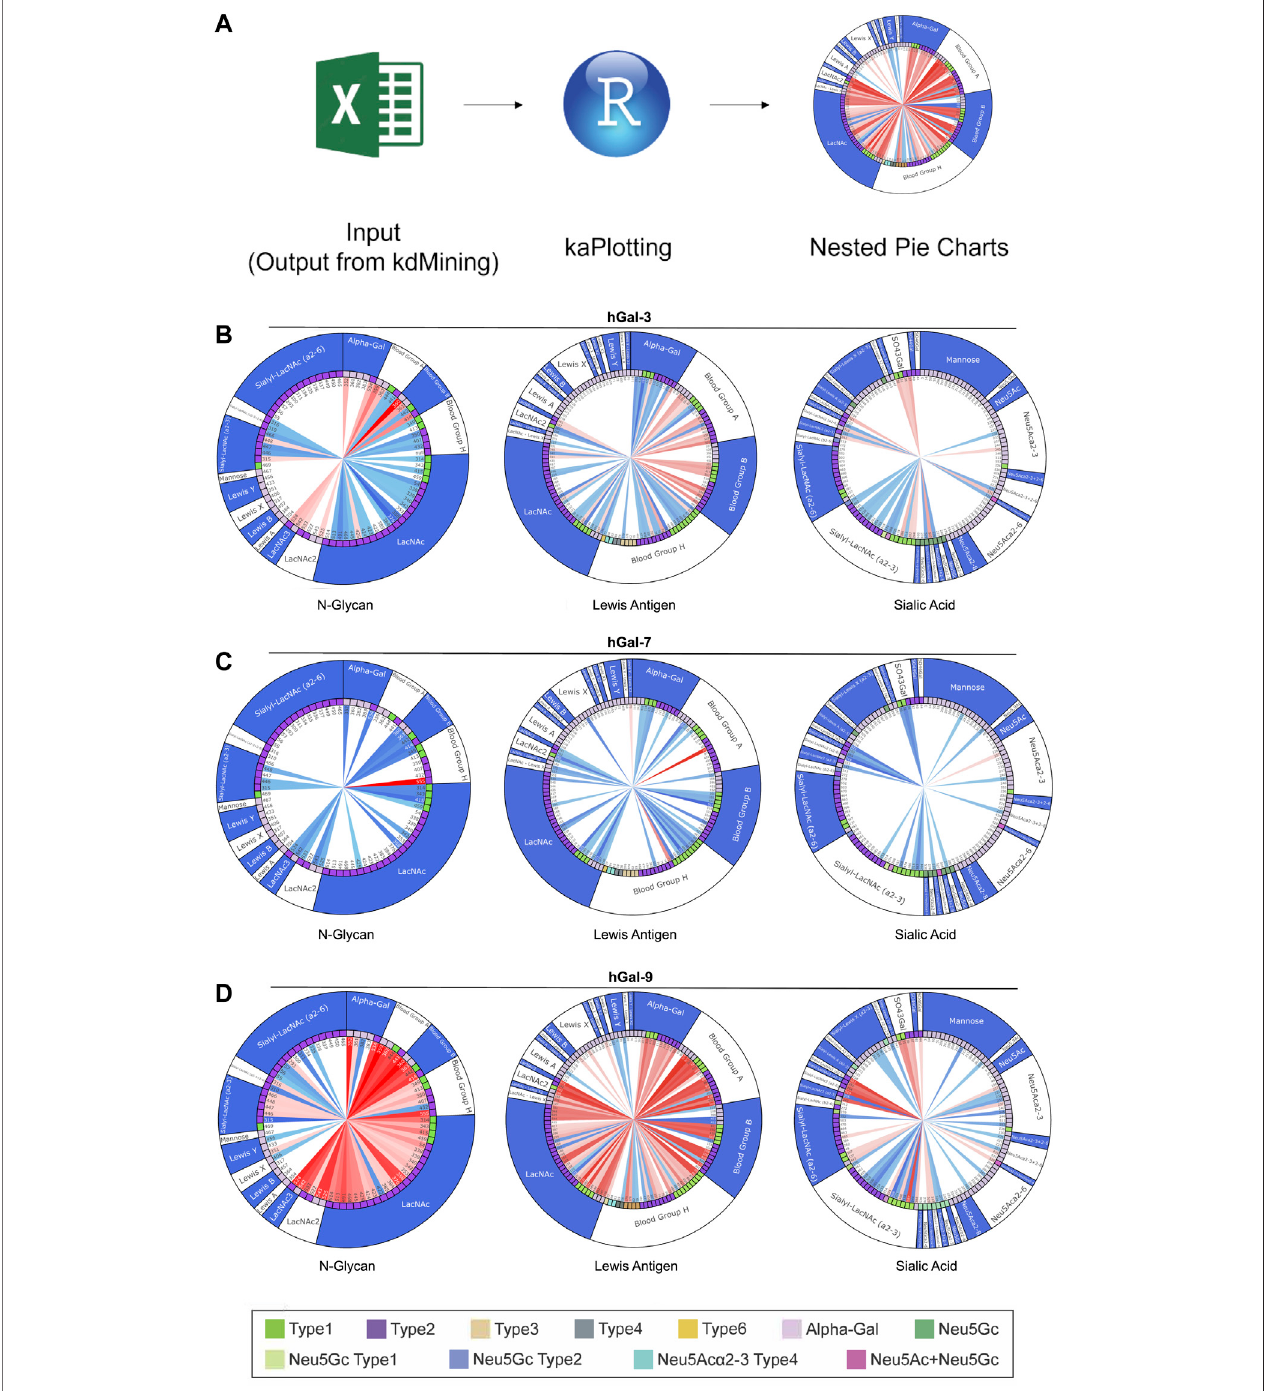
FIGURE5| DemonstrationofkaPlotting ’ snestedpiecharts .(A) OverviewofkaPlotting intakesand processingsteps.Atotalofthreethree-layer-nestedpiecharts that consist of K A , glycan linkage, and glycan structure are generated. (B – D) Nested pie charts shown for Gal-3 (B) , Gal-7 (C) and Gal-9 (D) . Charts are grouped by N-Glycan, Blood Group Antigen, and Sialic Acid, and plotted using kaPlotting. Each nested pie chart has three layers of information: K A , glycan linkage, and glycan structure, from inner to outer, respectively. There are two sets of gradients: red and blue, that represent K A and % max respectively on the inner circle. For both gradients, darker tint = higher calculated value, lighter tint = lower calculated value. Legend at the bottom shows the glycan linkage (second layer on the nested pie charts). Type 1: Type 1 LacNAc and type 2: Type 2 LacNAc.